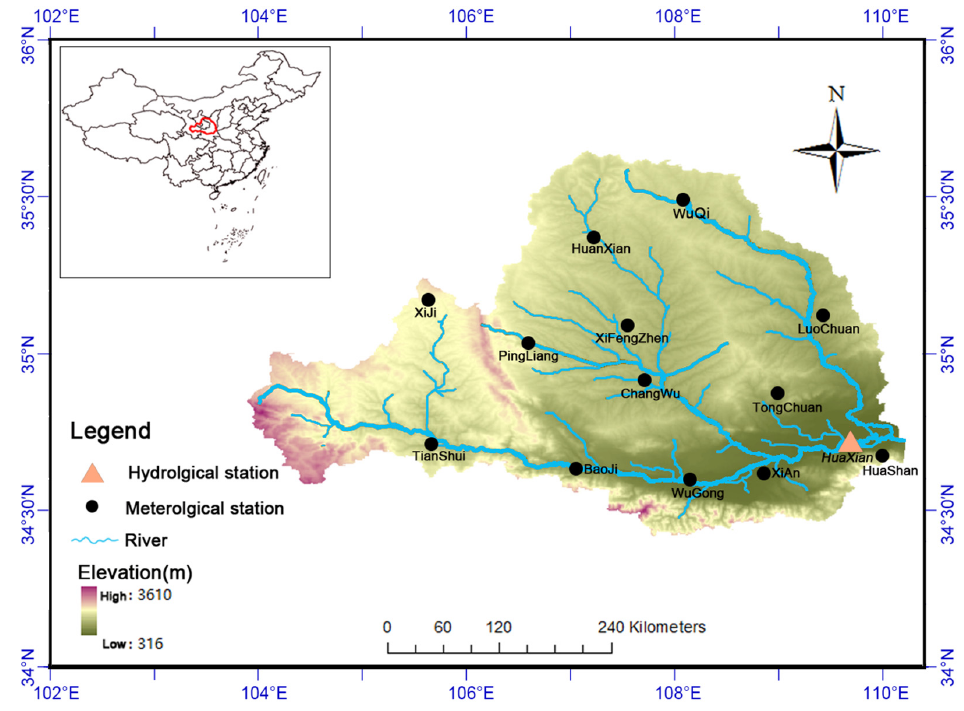
Figure 1. Study area, hydrological and meteorological stations in this study.